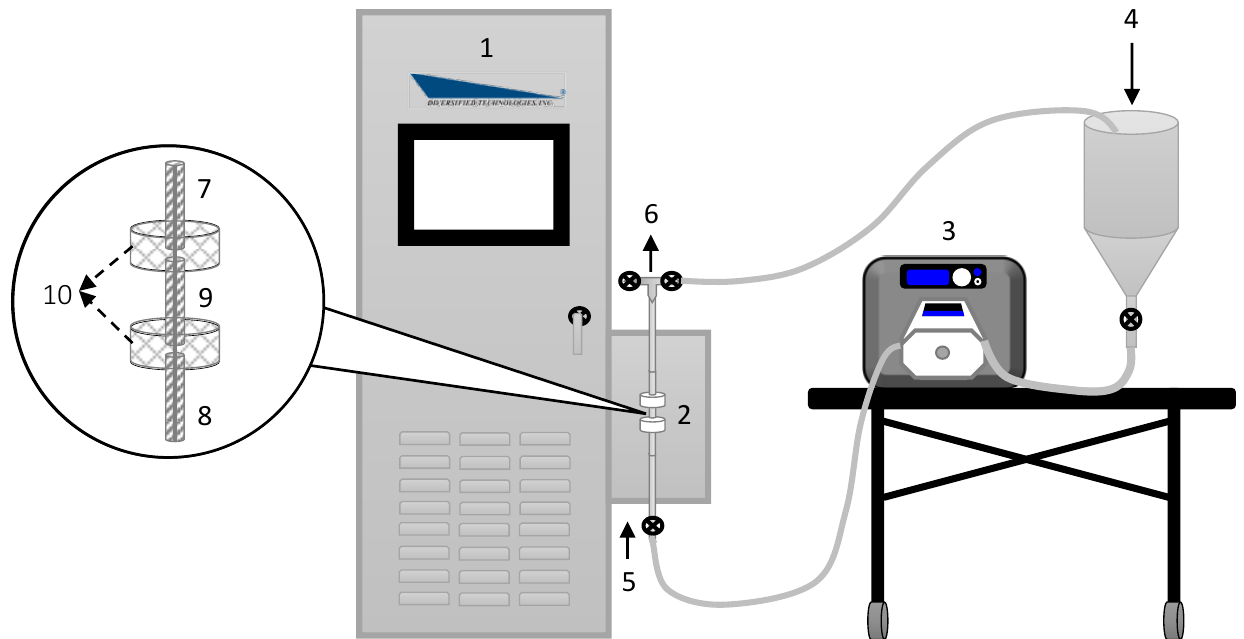
Figure 1. Schematic diagram of the experimental setup for pepsin inactivation by PEFs in hemoglobin hydrolysates: (1) modulator cabinet with display control, (2) treatment chamber, (3) peristaltic pump, (4) feed container, (5) solution inlet, (6) solution outlet, (7 and 8) low-voltage electrodes, (9) high-voltage electrode, and (10) ceramic isolators.